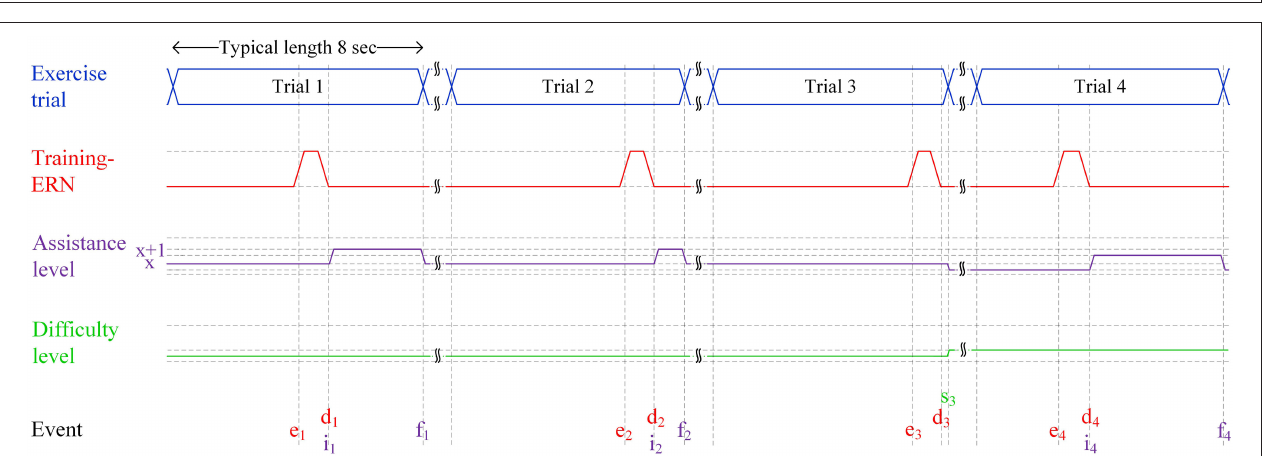
FIGURE 1 | Setup of the event-related negativity (ERN)-based robot-assisted stroke rehabilitation system (RASRS). The rehabilitation robot would assist the patient in performing the rehabilitation exercise as required. The instruction monitor would guide the patient in performing the rehabilitation exercise by showing relevant cues on the screen and would also show the real-time feedback of the movement of the impaired limb with the help of the Azure Kinect sensor, so that the patient can know how much exercise has been performed and how much it is left. The electroencephalogram (EEG) sensors record the EEG activity from the patient’s brain. The control unit would process the EEG data, the Kinect sensor data, give inputs to the instruction monitor, and signals the rehabilitation robot to increase/decrease the robotic assistance.